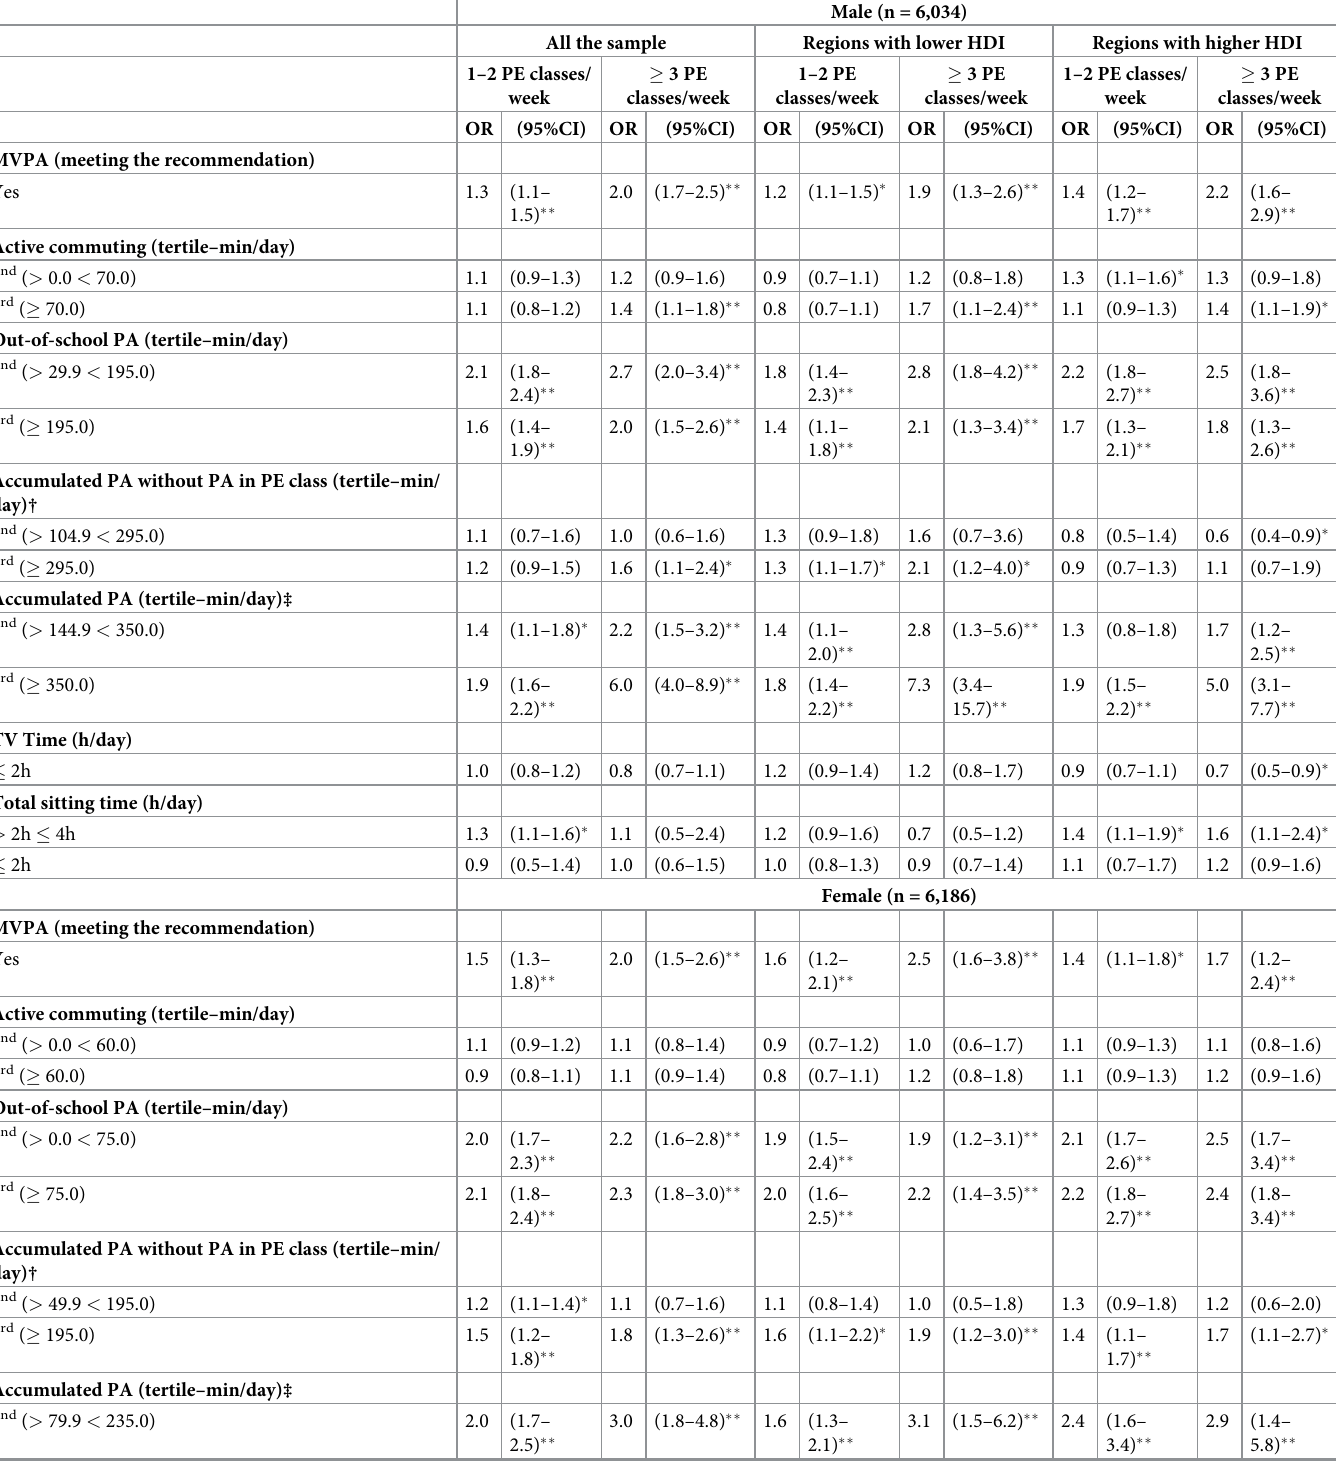
Table 2. Association between participation frequency in physical education classes and indicators of physical activity and sitting time according to sex and income level of the Brazilian regions (n =